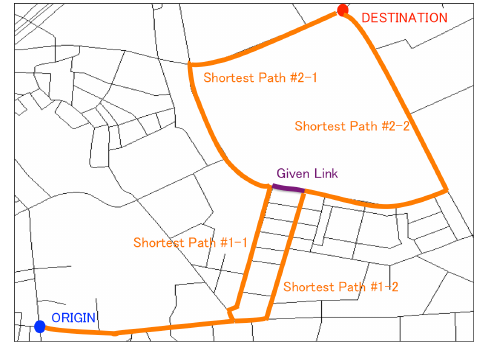
Figure 4. Application of GSP to the proposed